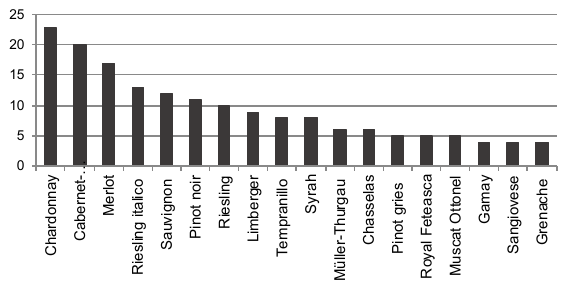
Figure 2. Number of reports of occurrence of the main rootstock varieties and their range in the regions where the survey was car- ried